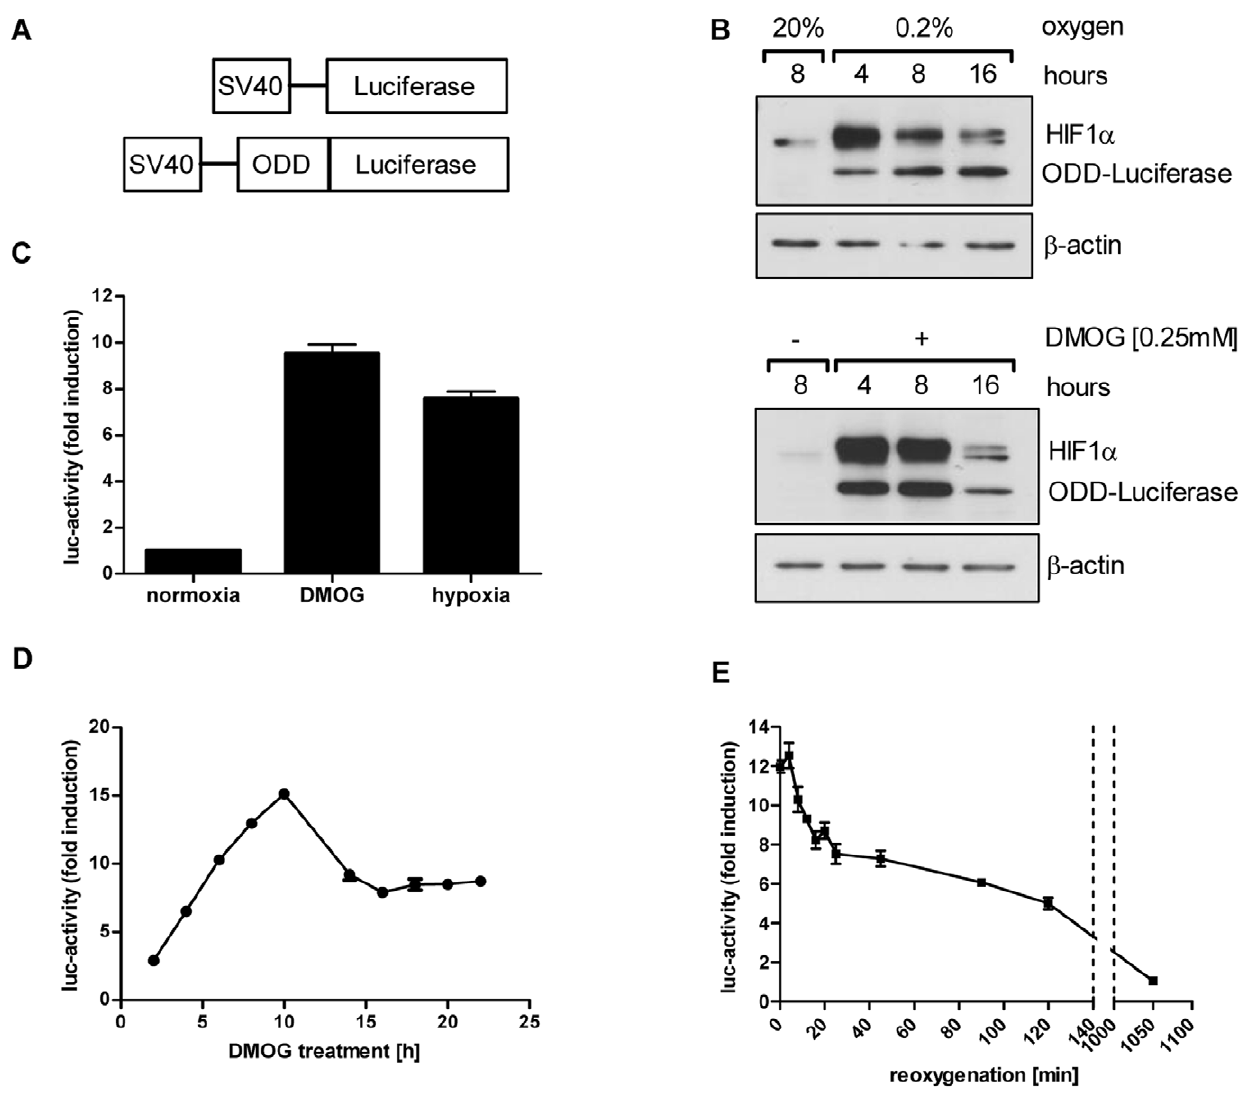
Figure 1. Oxygen-sensitive luciferase reporter system. (A) Scheme of luciferase constructs for constitutive (Luc) and oxygen-sensitive luciferase expression (ODD-Luc), containing a part of the oxygen-dependent degradation (ODD) domain of HIF-1 a . Both constructs are under the control of a minimal SV40-promoter. (B) Protein levels of HIF-1 a and ODD-luciferase in cellular extracts of stably transfected A549 cells, incubated for different time periods under normoxia, 0.2% O 2 or DMOG. (C) Luciferase activity in stably transfected ODD-Luc A549 cells. Cells were incubated for 8 hours under normoxia, DMOG or hypoxia. (D) Luciferase activity in DMOG-treated, stably transfected ODD-Luc A549 cells over a 22 hour period. (E) Luciferase activity in stably transfected ODD-Luc A549 cells kept for 8 hours under hypoxia and reoxygenated (time point 0 minutes) thereafter. Error bars represent mean 6 SE. doi:10.1371/journal.pone.0051476.g001 a maximum of 2.5-fold induction at the 14 hour time point after treatment (p , 0.05) and returned to basal levels 38 hours after treatment start. In comparison, luciferase activity in placebo- treated control mice did not change over this 38 hour period